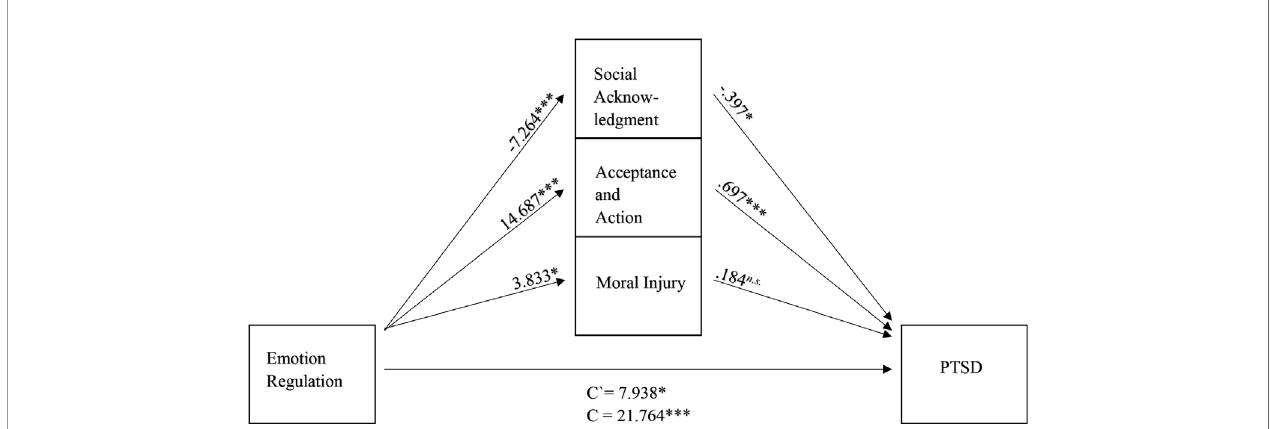
FIGURE 1 | Mediation model ( N = 72), with standardized beta weights and signi fi cant level for the relationship between ER and PTSD, mediated by SA, AA, and MI. 95%- CI , 95%-Con fi dence interval; Emotion Regulation measured by the DERS, Dif fi culties in Emotion Regulation Scale; Social Acknowledgment measured by the SAQ, Social Acknowledgment as a Victim or Survivor Questionnaire; Acceptance and Action measured by the AAQ-II, Acceptance and Action Questionnaire-II; Moral injury measured by the MIES, Moral Injury Event Scale; PTSD measured by the CAPS-5; n.s. , not signi fi cant; * p <.05; *** p <